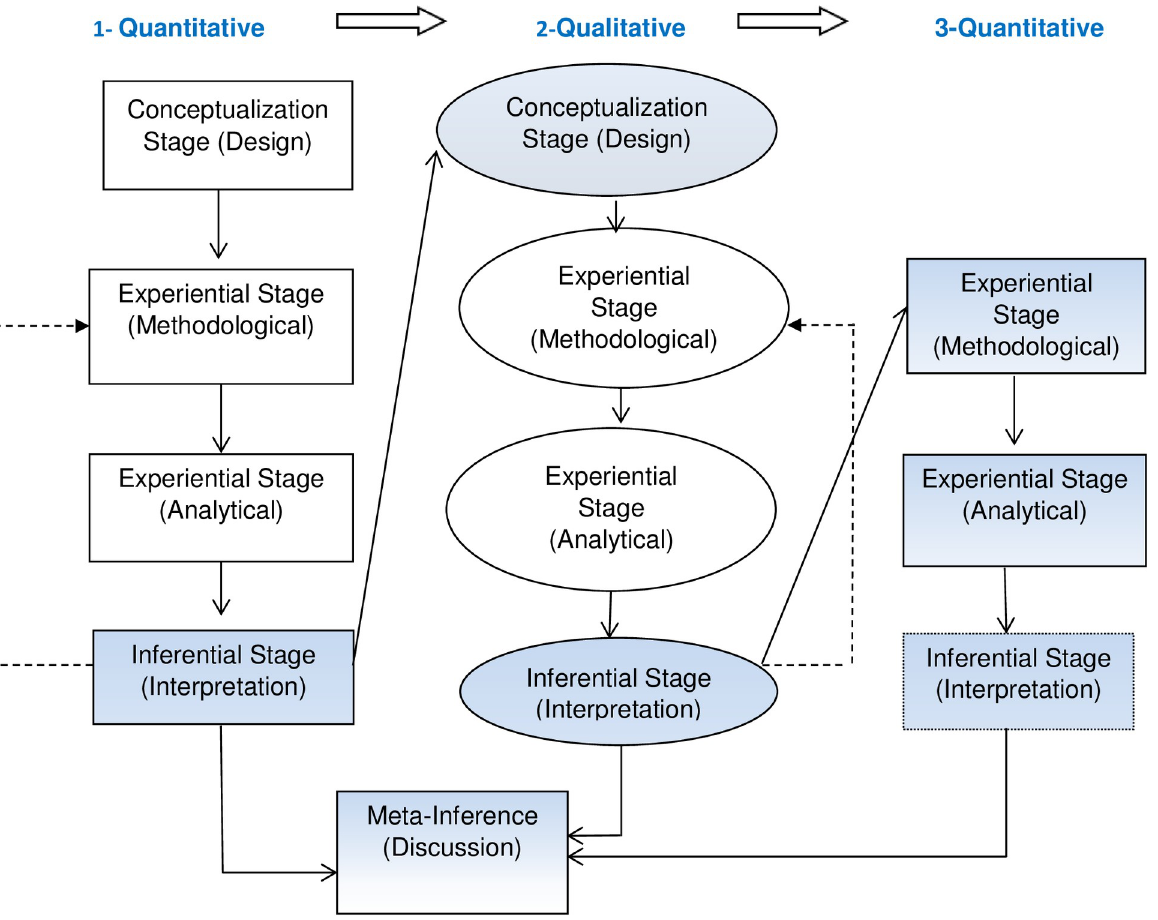
Fig 1. The mixed-method design used for this study, adopted from Teddlie